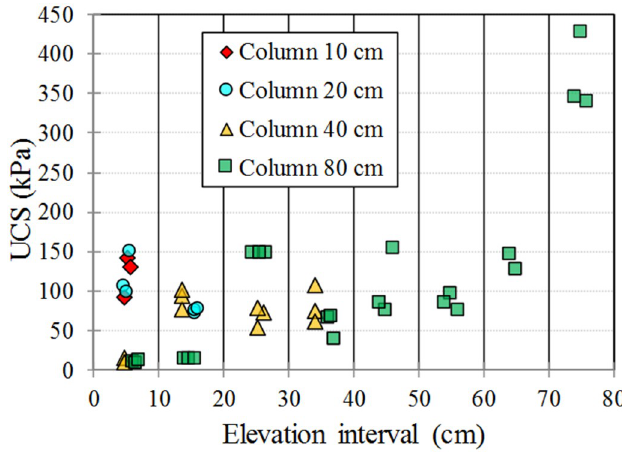
Figure 8. Variations of uniaxial compressive strength of cemented hydraulic fill samples taken from columns of 10 cm, 20 cm, 40 cm, and 80 cm height; the elevation measured from the bottom of the columns.